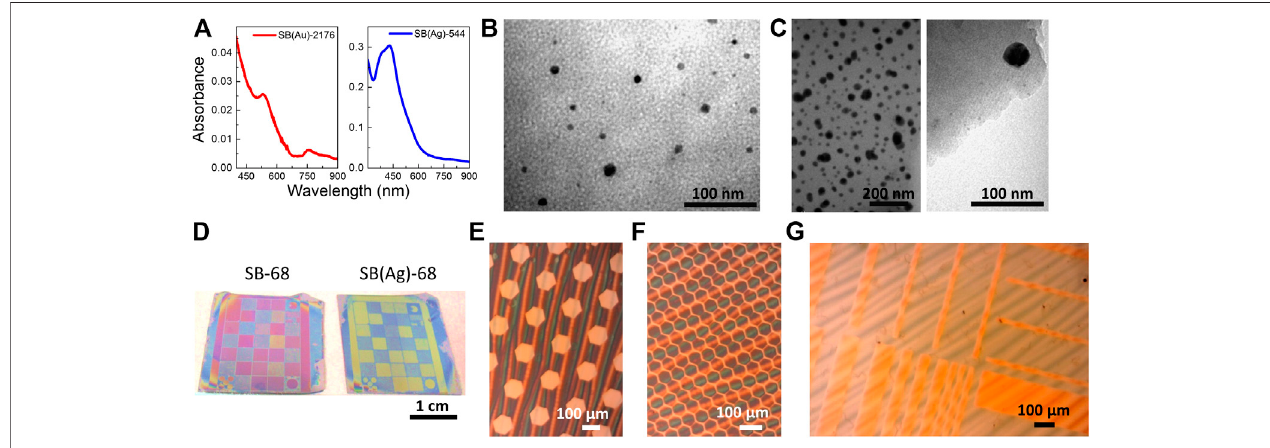
FIGURE7|(A) UV-visiblespectra ofSB(Au)-544and SB(Ag)-2176 samples;systems weredeposited ontofused silicatoobtain these spectra. TEMimages of (B) SB(Au)-544 and (C) SB(Ag)-2176 samples. (D) Pictures of SB-68 and SB(Ag)-68 patterned samples. Optical microscope images of (E,F) sections of SB-68 patterned sample and (G) a section of SB(Ag)-68 patterned